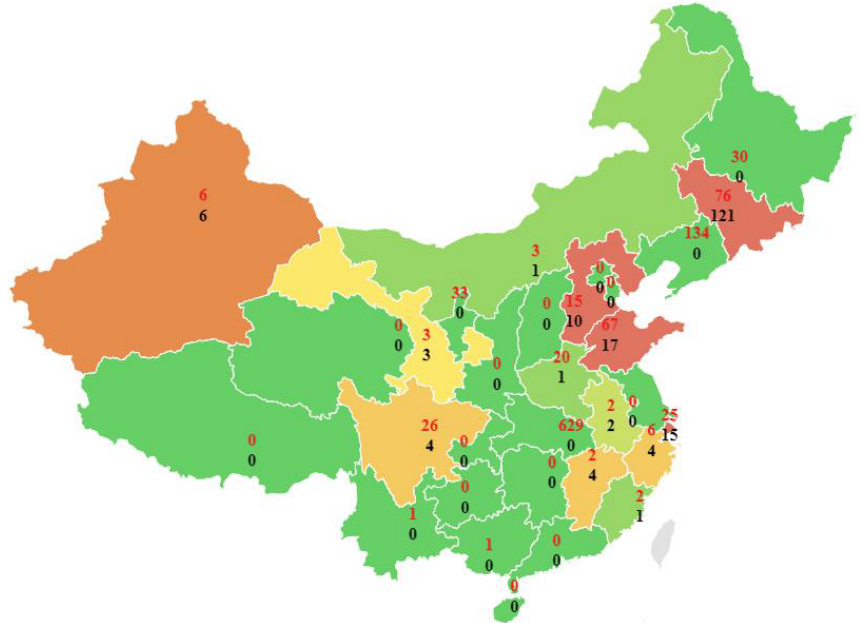
Figure 5. Fatalities and injuries distribution of ArRAs by 31provinces (excluding Hong Kong, Macau, and Taiwan).